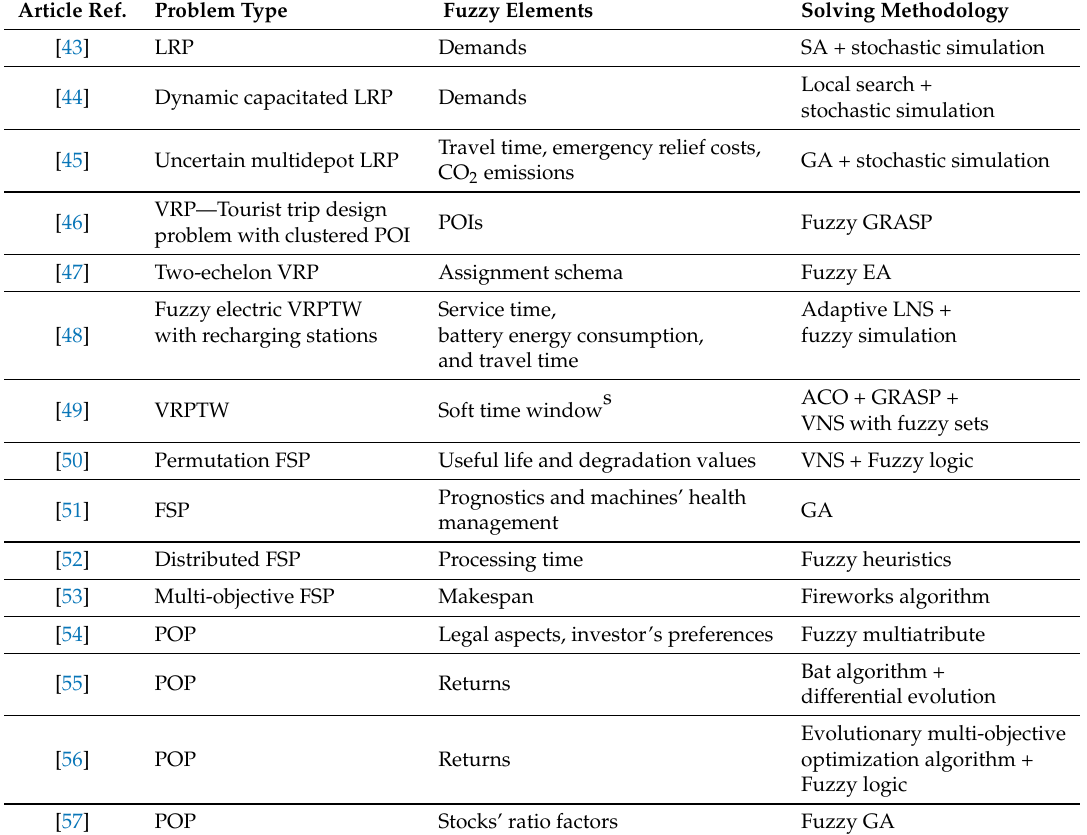
Table 1. A summary of different works combining heuristics, simulation, and fuzzy-related techniques. Article